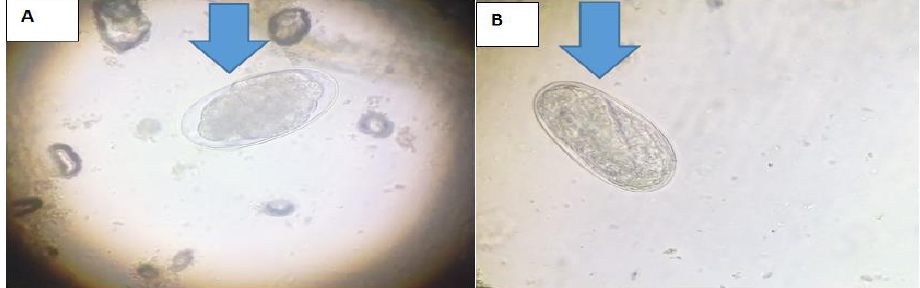
Fig 1: Eggs of GIPs (A) Strongylus spp (B) Strongyloides spp.